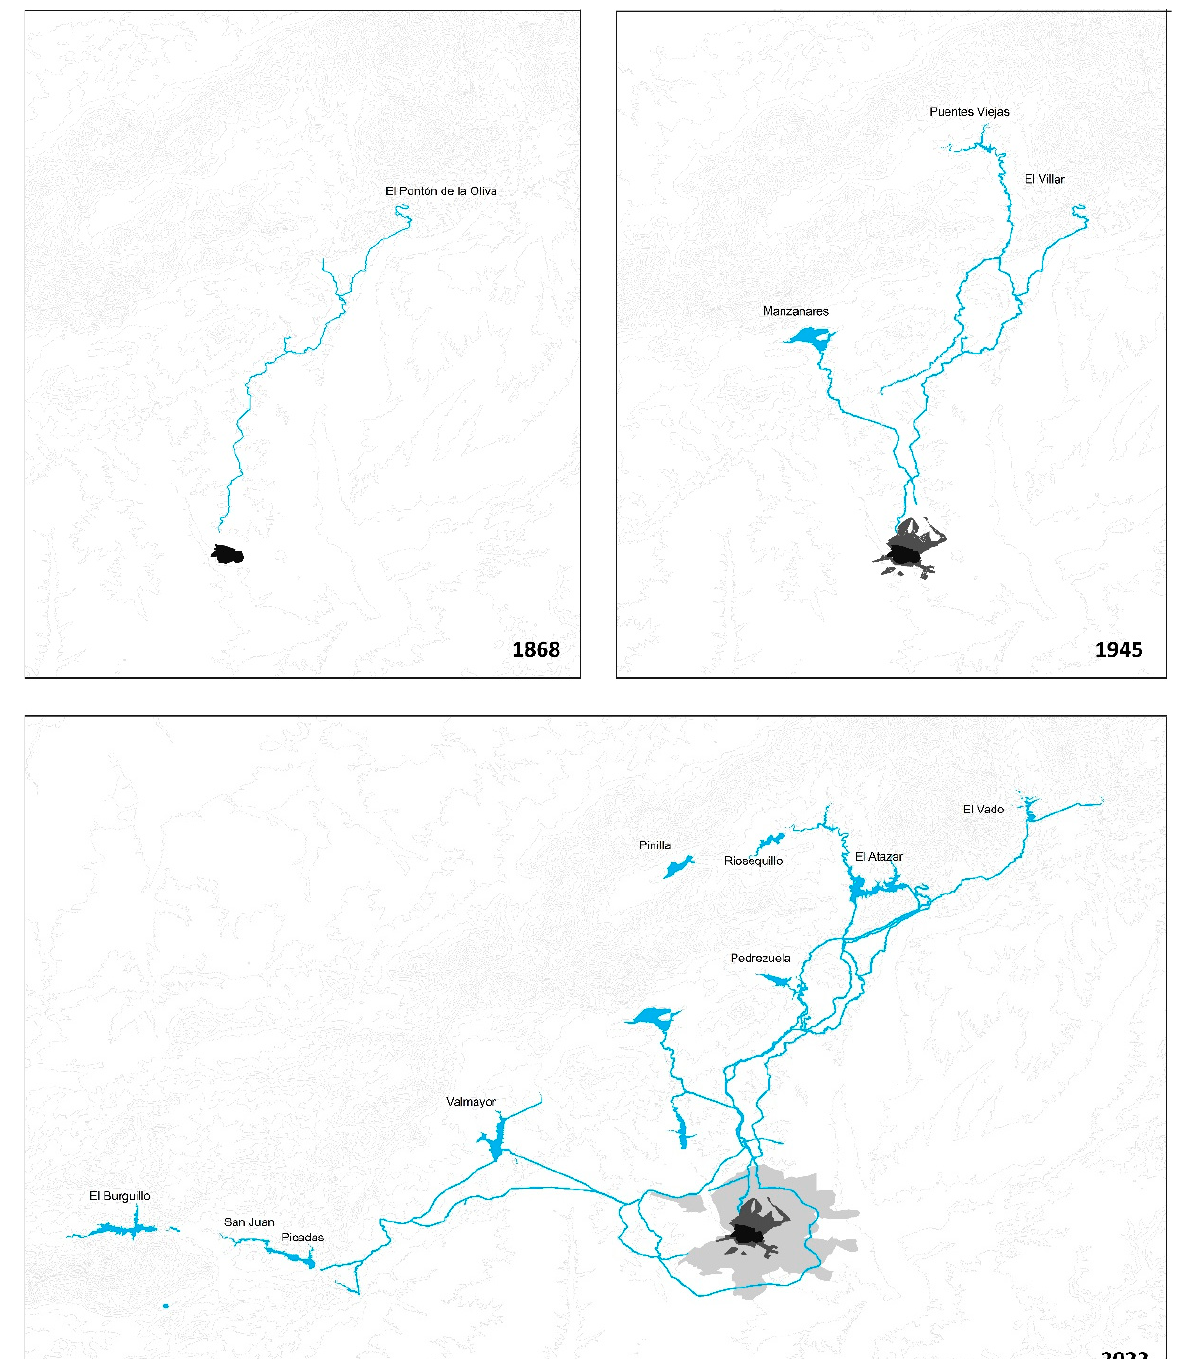
Figure 4. Evolution of the water supply network and the urban nucleus of Madrid: 1868, 1945 and 2022. Source: Created by the authors.